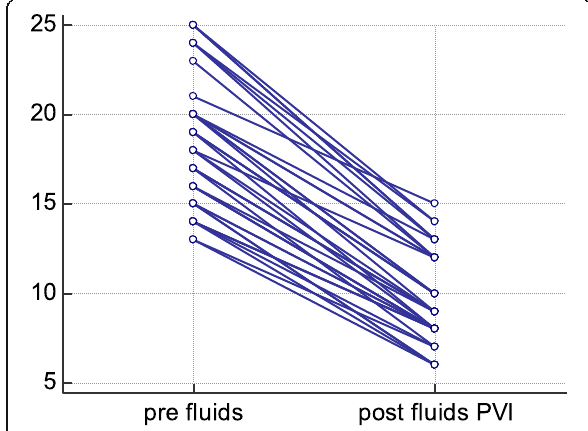
Fig. 2 Individual range of PVI for fluid responsiveness. Individual range of PVI finger probe after 5 ml/kg fluid bolus